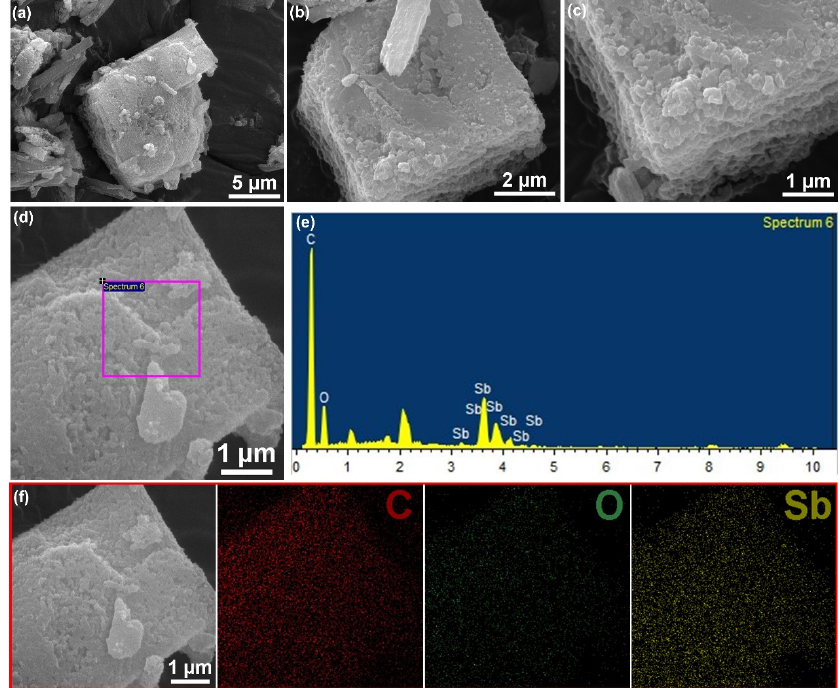
Figure 3. ( a – c ) SEM images at different magnifications of MOF ‐ Sb–C. ( d ) The EDX surface scan area and ( e ) the corresponding EDX element results. ( f ) SEM image of MOF ‐ C–Sb and corresponding elemental mapping.